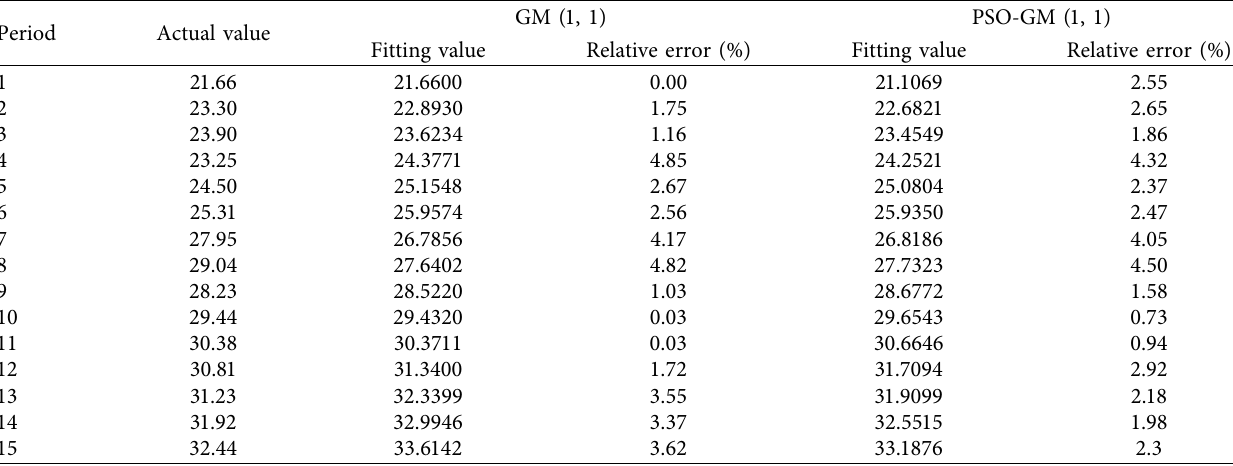
Table 10: Actual and simulated results of B16.